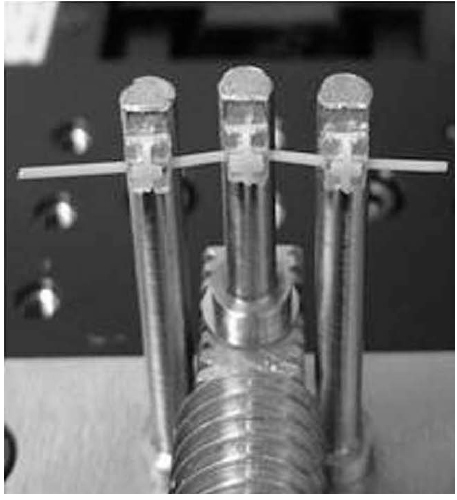
Figure 11. Slot lid ligature.